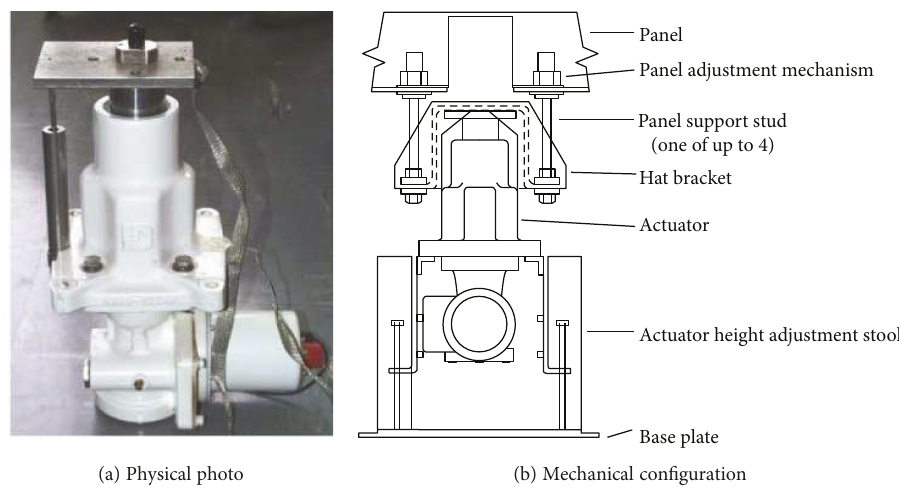
Figure 5: GBT actuator [63].